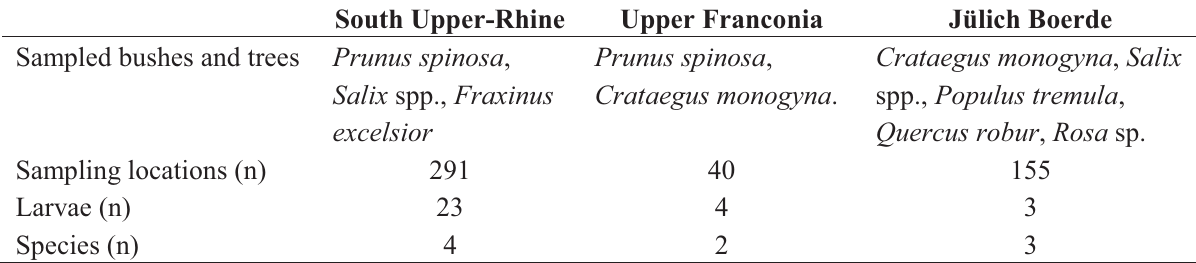
Table 6. Beating samples of Lepidoptera larvae in the three study regions. Sampling location denotes one branch with one double-hit. Note that the regions differ in sampling intensity (see Table